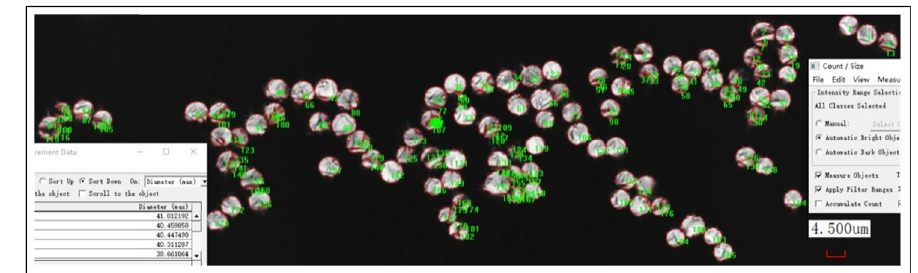
Figure 4: Measurement of mono fi lament diameters.